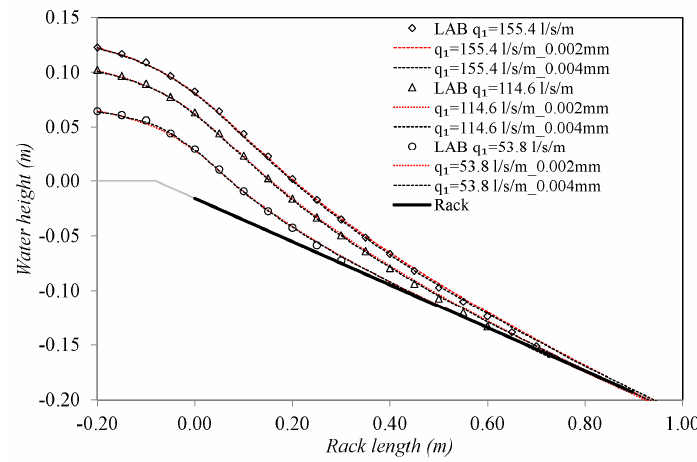
Figure 4. Flow profiles over the center of the bar with 20% rack slope as a function of the mesh size.